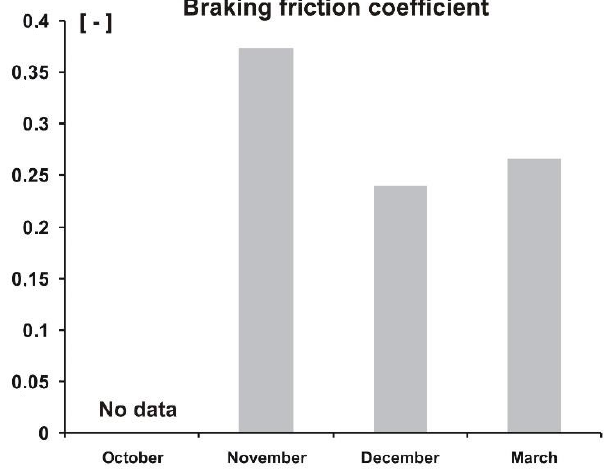
Figure 15. Average peak values of braking friction coefficient, μ , for the four measurements.